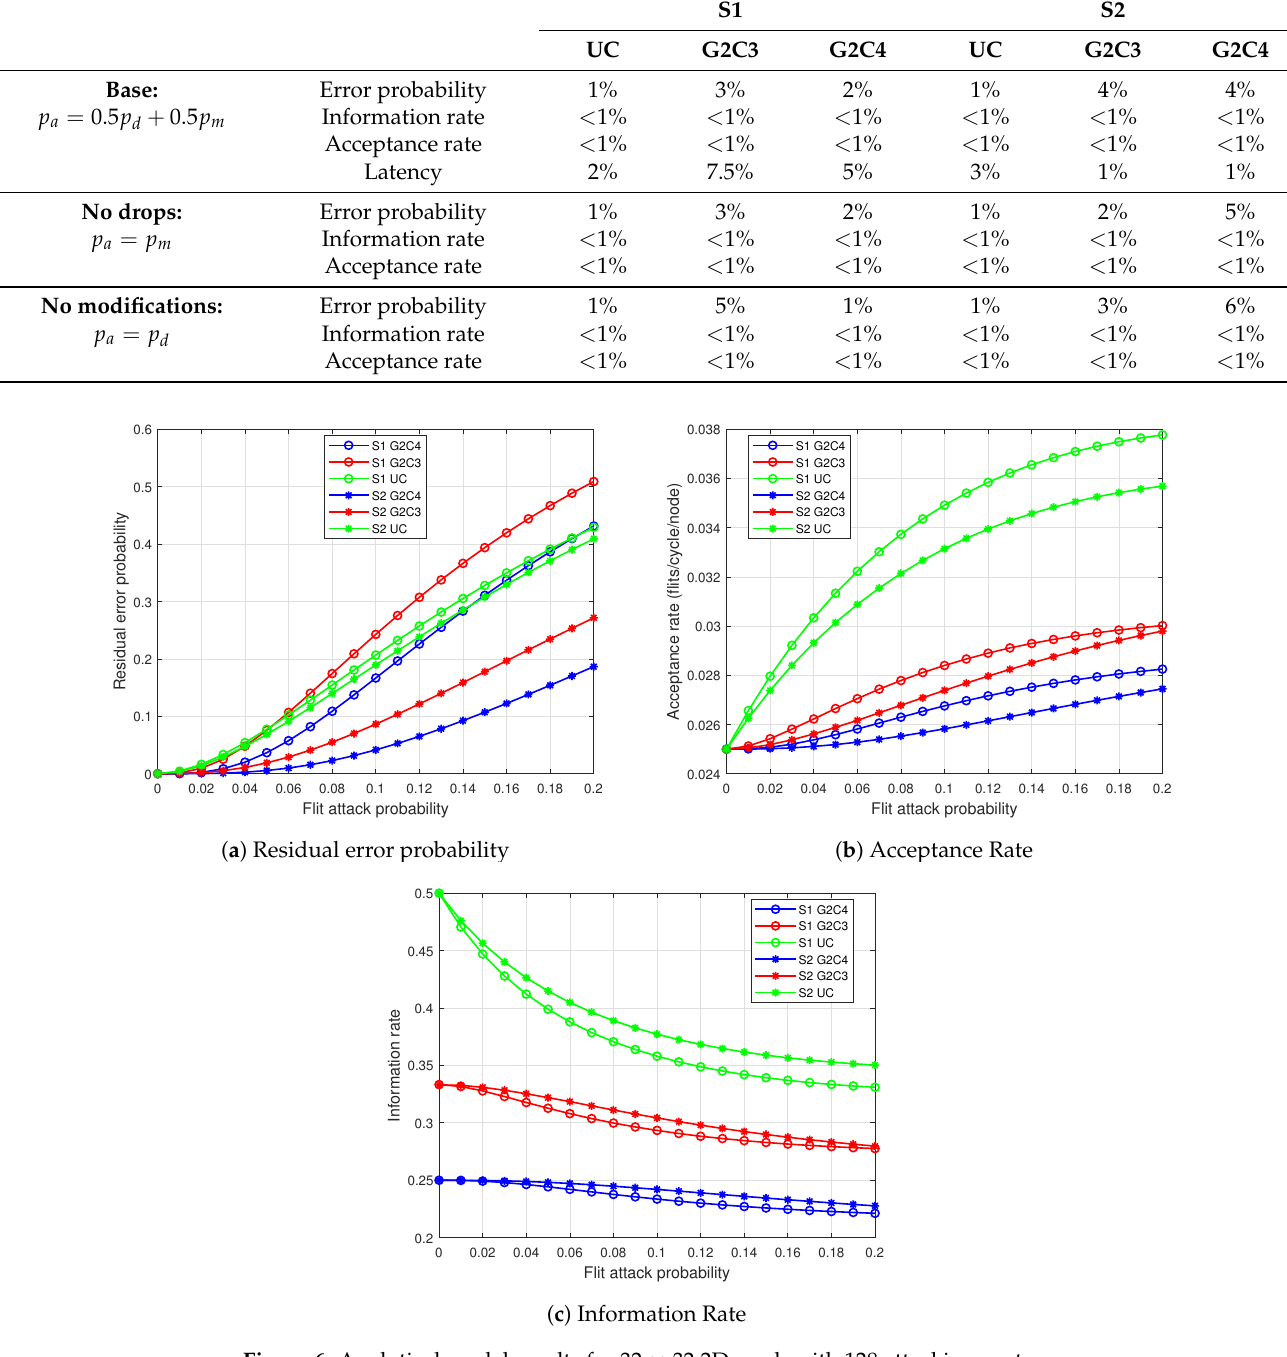
Figure 6. Analytical model results for 32 × 32 2D mesh with 128 attacking routers. Since there is a significantly higher probability of passing through an attacking router in the 32 × 32 NoC, we can expect significantly higher rates of flit drops and modifications. As a result, residual error rates (Figure 6a) are considerably higher in comparison to the 8 × 8 NoC. Similar to the performance for 8 × 8 NoC, in the 32 × 32 NoC S2 behaves better than S1: S2/G2C4 has less than half the residual error probability of S1/G2C4 at 0.2 flit attack probability. For G2C3, S1 has a 87% higher residual error probability than S2 at 0.2 attack probability. For UC case, the performance of S1 and S2 are